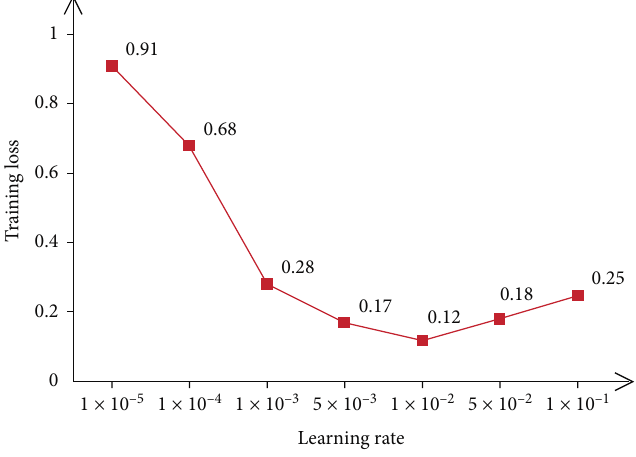
Figure 6: The change of training loss with learning rate.